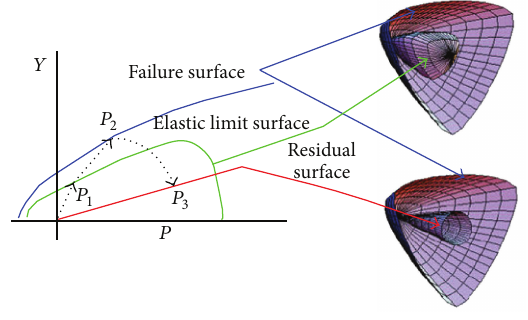
Figure 1: RHT three strength surfaces [1].